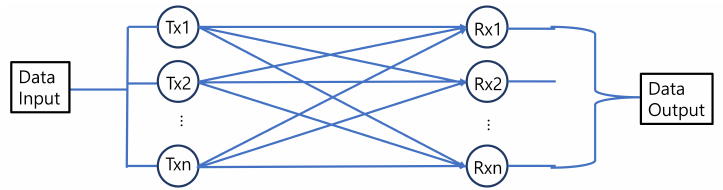
Figure 5. RC MIMO that each of the transmitters sends same data